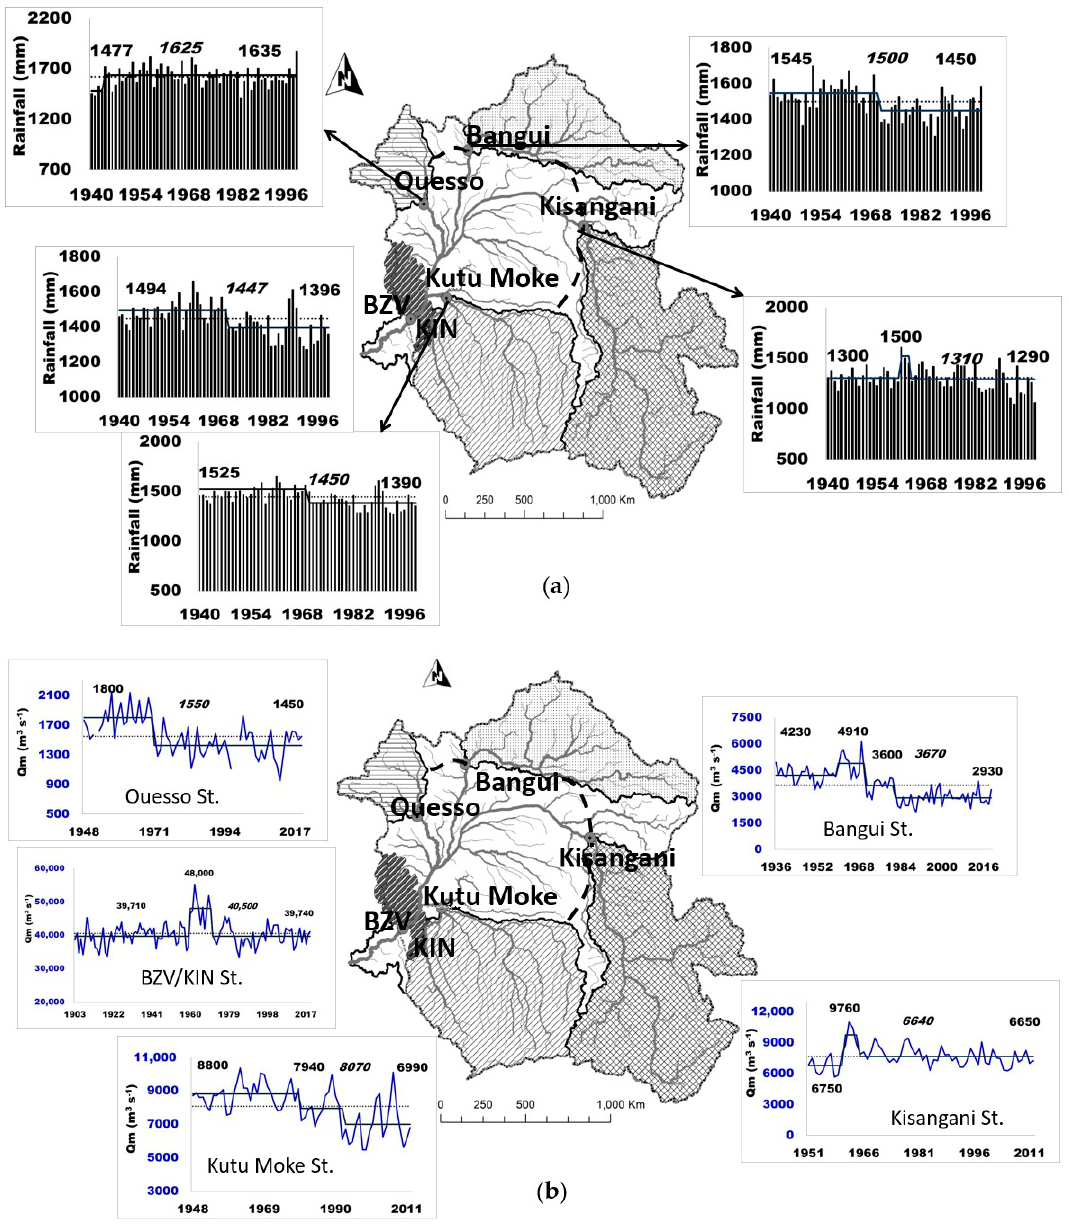
Figure 9. Graph discontinuities in the annual ( a ) rainfall and ( b ) hydrological chronicles of the five main drainage units studied from field data, including that of the entire Congo Basin. Legend: Values in italics are the interannual averages of the entirety of each series studied. (Rainfall series comes from www.hydrosciences.fr/sierem) [6] and Discharges series from https://hybam.obs-mip.fr/database [22].